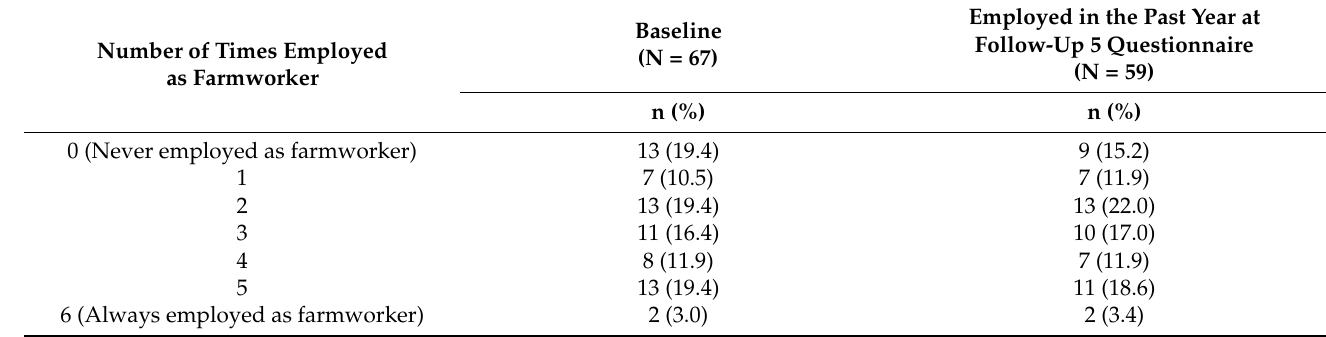
Table 3. Frequency of Employment as a Farmworker for Baseline Sample (N = 67), and Those Employed in the Past Year at Follow-Up 5 Questionnaire (N = 59), Latinx Women in Farmworker Families, North